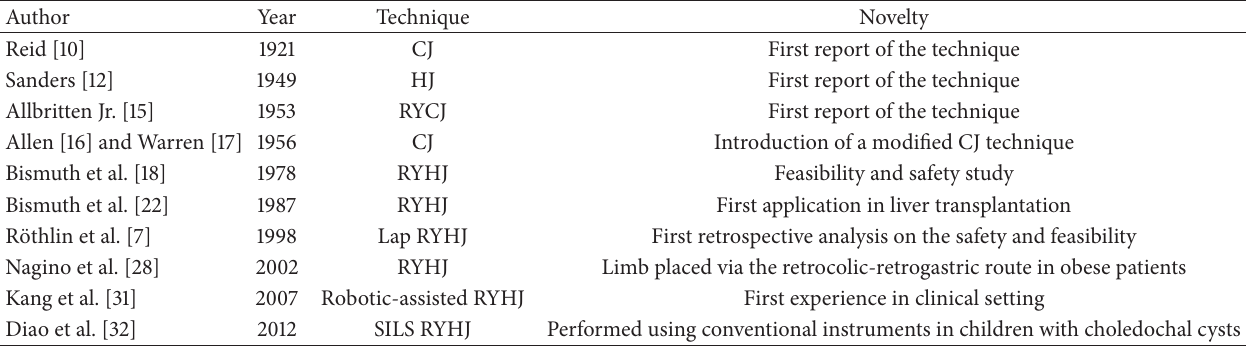
Table 1: Milestones of the evolution of biliary diversion techniques.